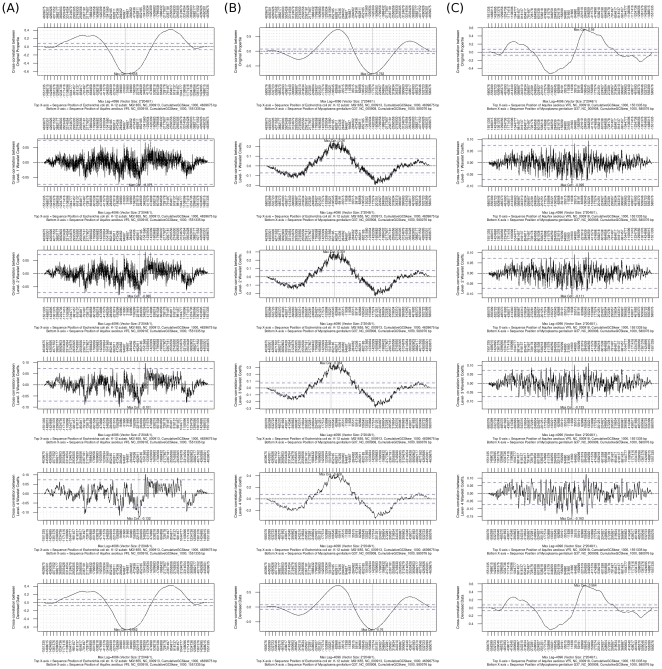
Results of cross-correlation analysis for the three cumulative GC skews of the chromosomes of E. coli, M. genitalium and A. aeolicus.
Figure 8 shows the results of pairwise cross-correlation for the cumulative GC skews of the chromosomes of (A) E. coli and A. aeolicus, (B) E. coli and M. genitalium, and (C) A. aeolicus and M. genitalium. In order to estimate all possible conditions of cross-correlation between two genomic properties, the lags used in this example are ranged from maximum negative lag to maximum positive lag. Lags may indicate different positions of two genomic properties because cross-correlation compares two independent genomic properties that may have different sequence lengths. Therefore, two X-axes are used to label the shifting lags (sequence positions) of two genomic properties. The top X-axis represents the sequence positions of a phase-fixed genomic property; the bottom X-axis represents the sequence positions of a phase-shifted version of genomic property. The Y-axis represents the degrees of cross-correlation coefficients at different lags. A vertical solid gray line is used to point out the position of the maximum correlation of two genomic properties. The two horizontal blue lines are the 99.9% of confidence interval (0.073).